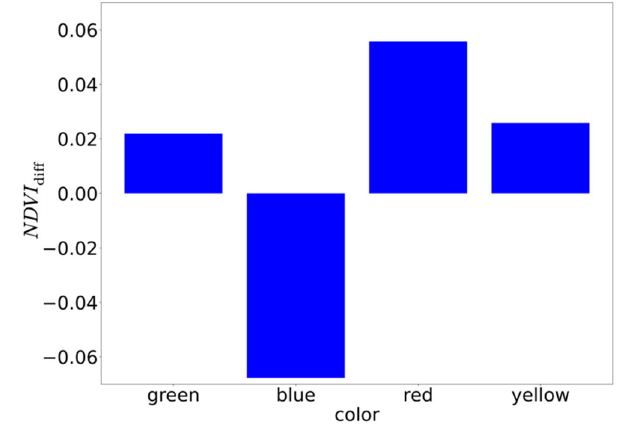
Figure 16. Average NDVI diff values over the CSs corresponding to each color.